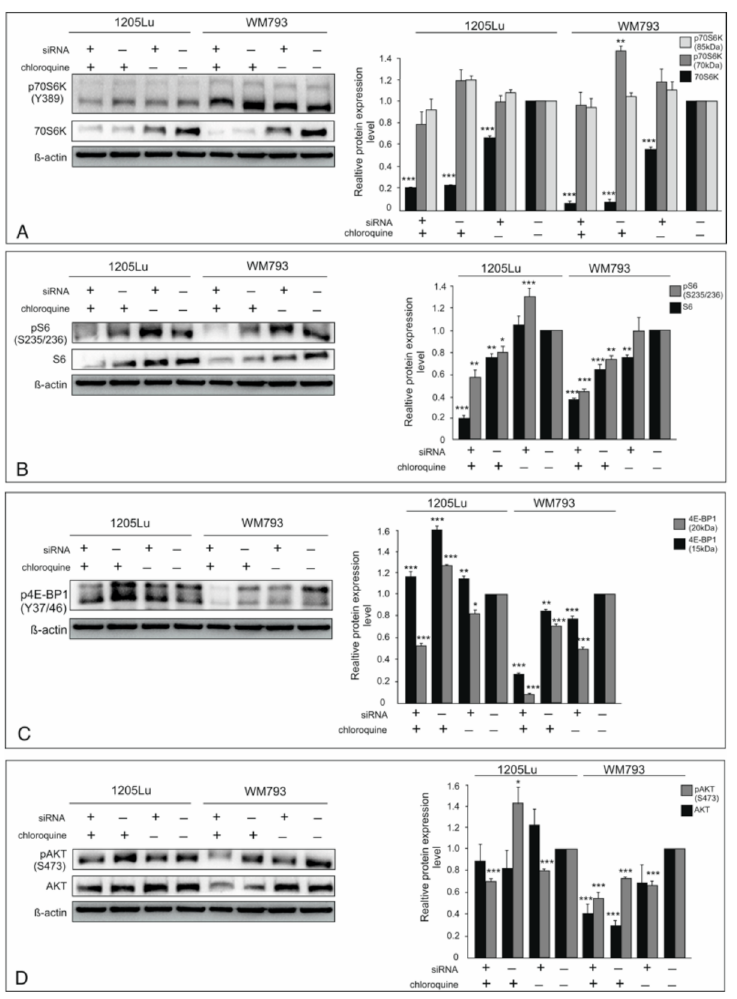
Figure 4. The effect of ILK silencing and CQ use on downstream of the mTOR signaling pathway. “+” refers to siRNA ILK or chloroquine; “ − ” refers to silencer negative control cells. Protein expression, both phosphorylated and total, was assessed by Western blotting. Representative blots are displayed. The histograms are a quantitative representation of data after densitometry (mean ± SD) of three independent experiments. β -actin was used as a protein loading control. Asterisks indicate significant differences from control cells. Values are denoted as * p < 0.05, ** p < 0.01, and *** p < 0.001. ( A